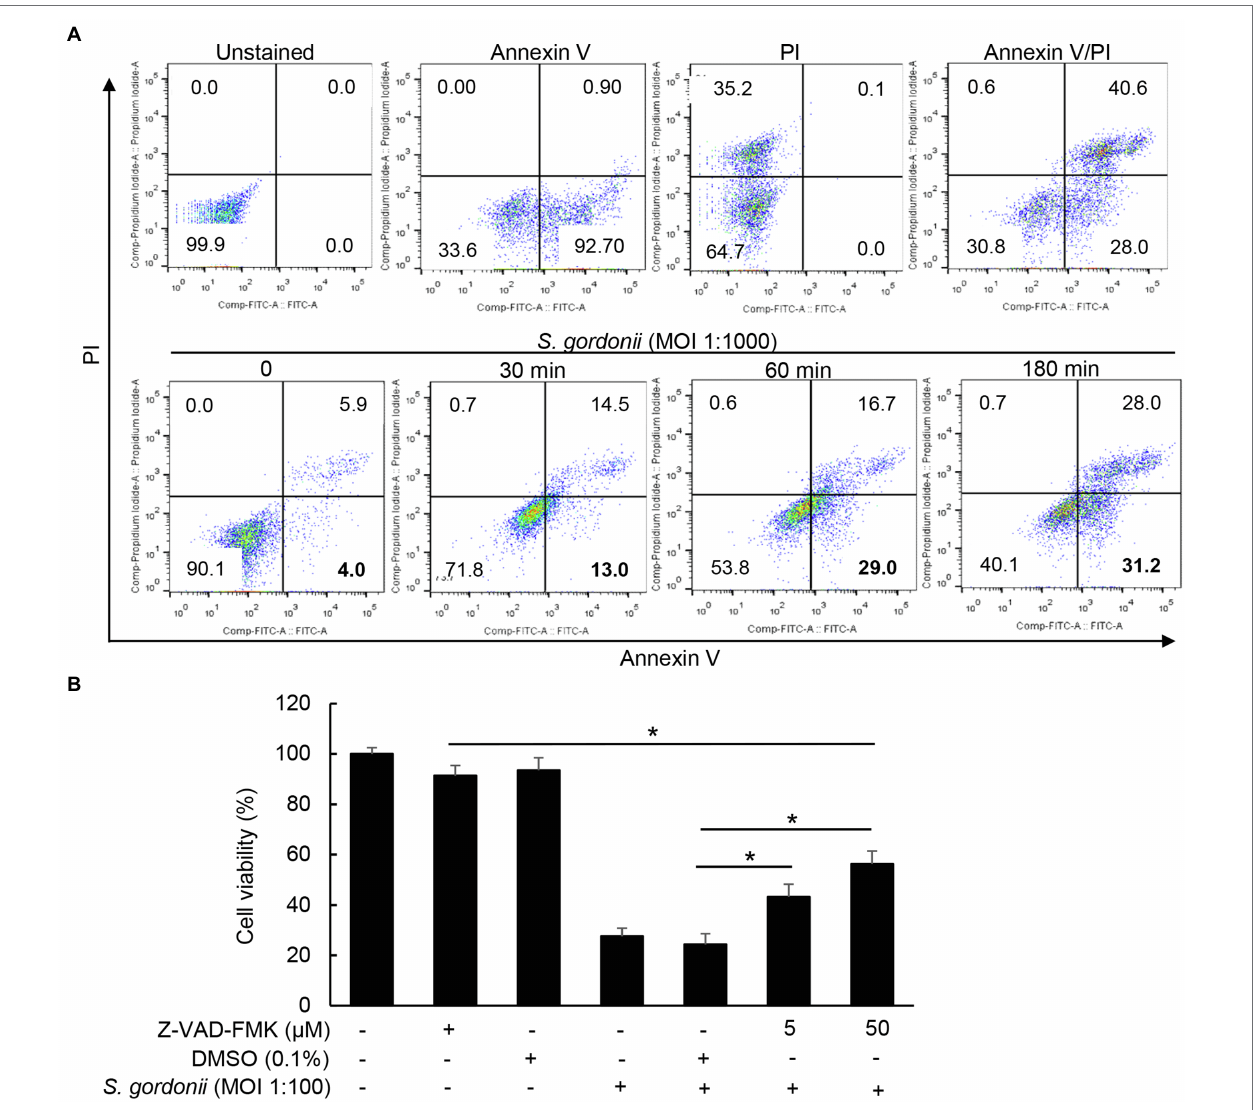
FIGURE 2 | Cytotoxicity by S. gordonii is mediated through apoptosis in PDL cells. S. gordonii was cultured to mid-log phase in THY media at 37 ° C. (A) PDL cells were treated with S. gordonii at MOI 1:1,000 for 30, 60, or 180 min. The cells were stained with annexin V and PI and then analyzed using flow cytometry. Numbers indicate the percentage of cells in each panel. (B) PDL cells were pre-treated with Z-VAD-FMK (0, 5, or 50 μ M) for 1 h, followed by treatment with S. gordonii at MOI 1:100 for 3 h. Trypan blue assay was used to determine the number of viable PDL cells. The cells were counted. One of three similar results is shown. * p <